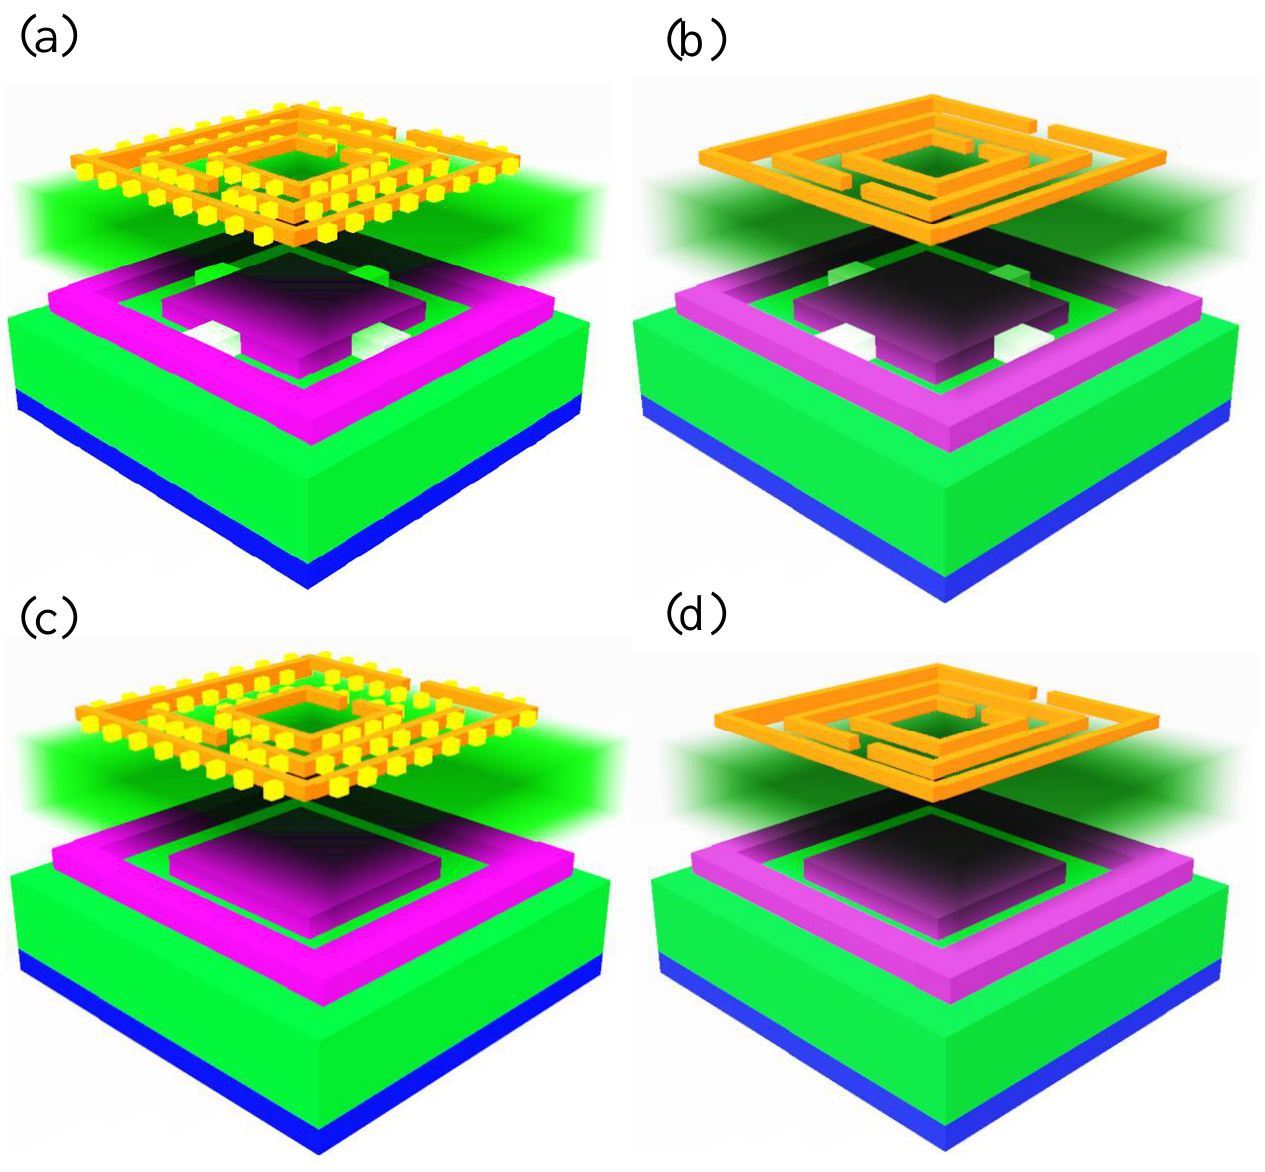
Figure 5. ( a ) The first design is the connected patch inner and patch outer (CPIO) and the SRR with the tooth (SWT) ( b ) Second design is the combined patch inner and patch outer (CPIO) and the SRR without a tooth (SWOT) ( c ) Third design is the disconnected patch inner and patch outer (DCPIO) and the SRR with the tooth (SWT) ( d ) Fourth design is the switch disconnected patch inner and patch outer (DCPIO) and the SRR without a tooth (SWOT). Table 1. Different proposed structures. Design